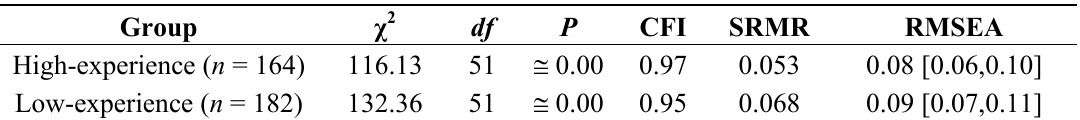
Table 3. Fit indices for the three-factor structure among social workers with high and low work experience, second-split sample ( n = 403).